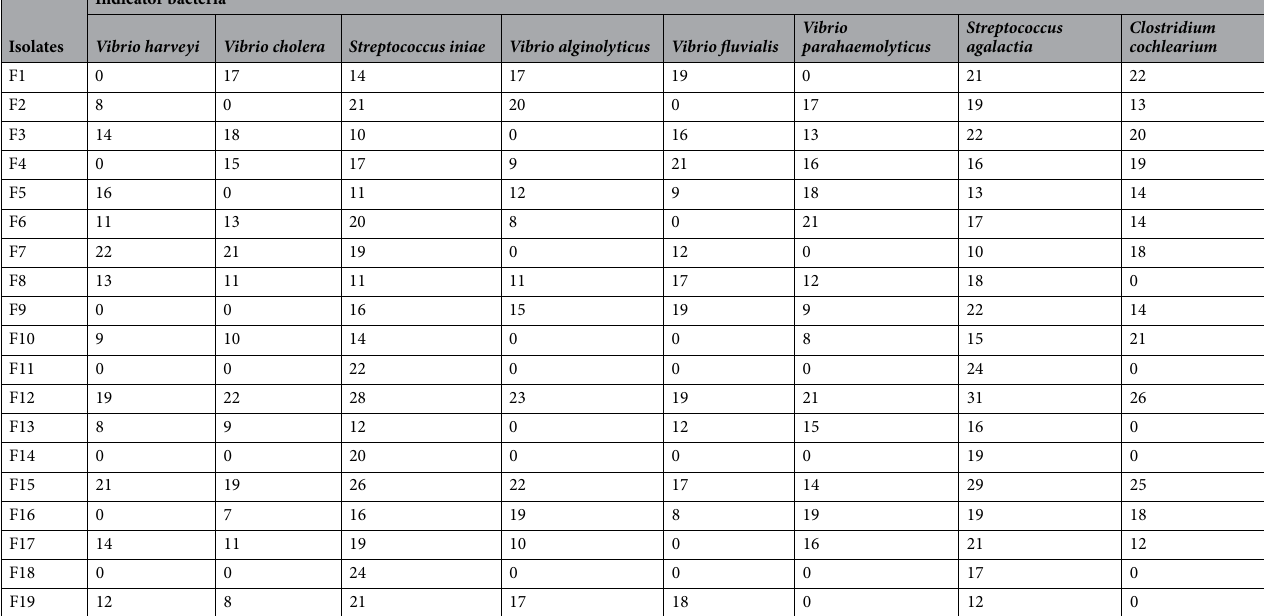
Table 1. Zone inhibition (mm) of antimicrobial properties of isolates.